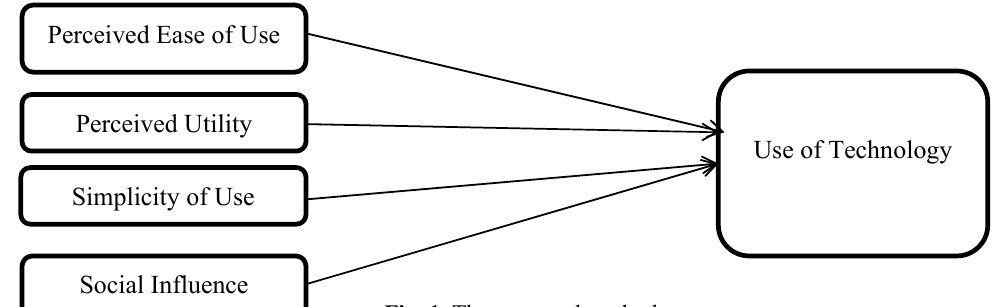
Fig. 1. The proposed method